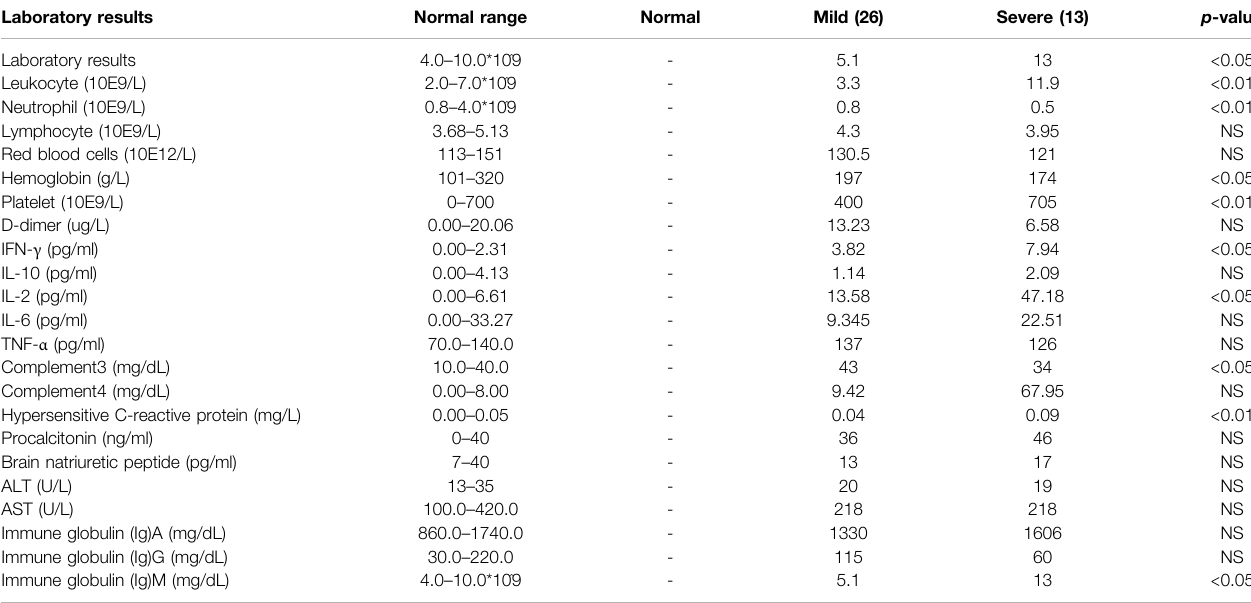
TABLE 2 | Laboratory results of hospitalized patients with infected SARS-Cov-2. Laboratory results Normal